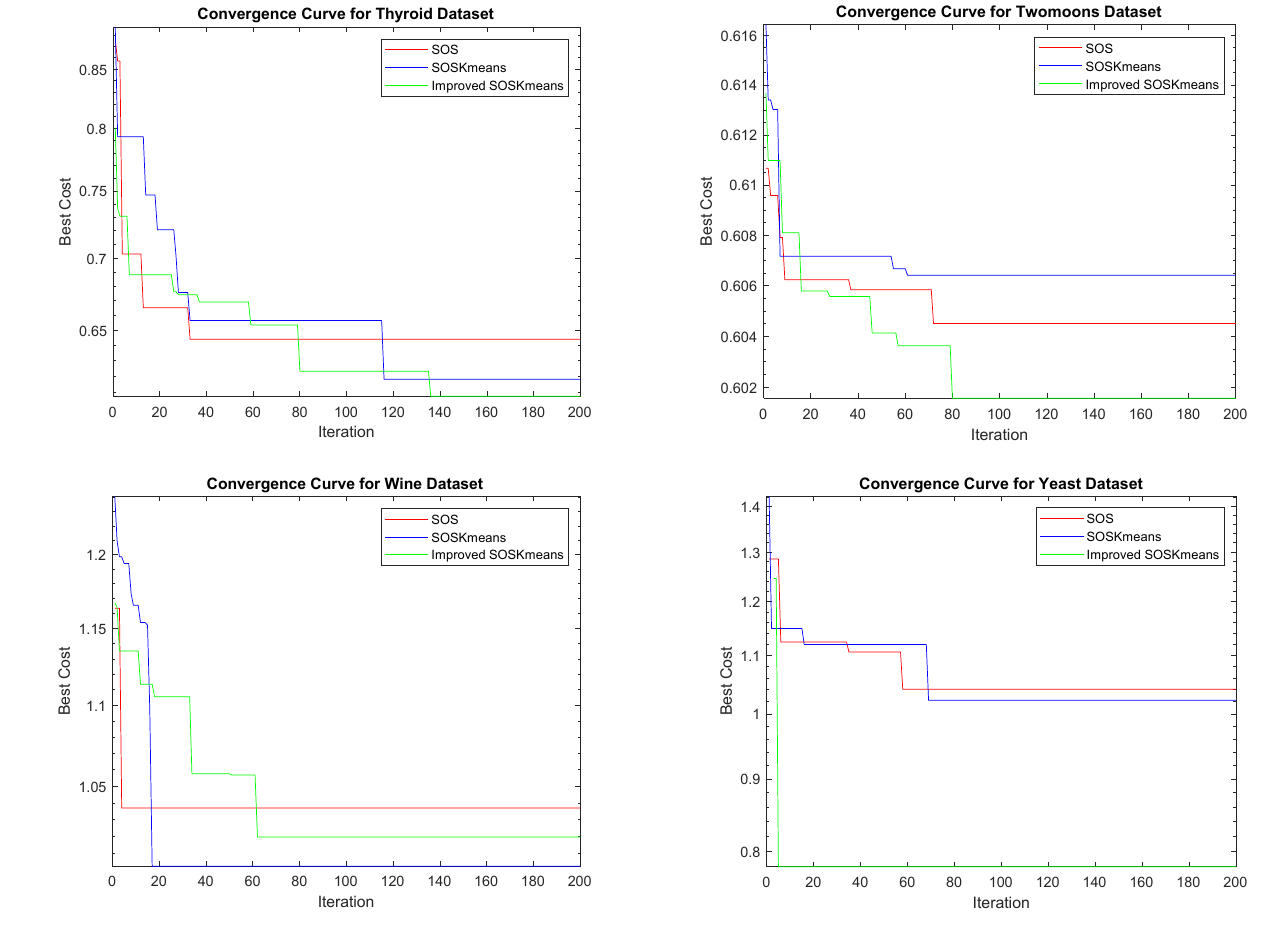
Figure 8. Convergence curves for the 12 datasets under DB index.